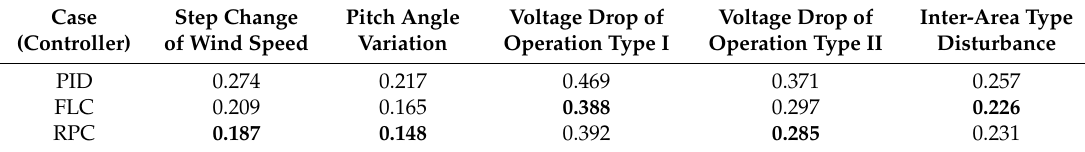
Table 3. Overall control costs of different controllers obtained in different scenarios